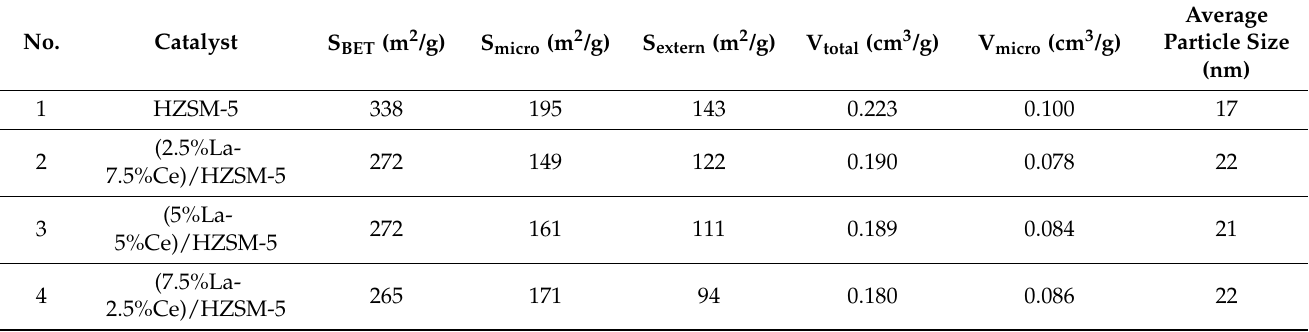
Table 2. Texture properties of the parent HZSM-5 and Lanthanum-Cerium-modified HZSM-5 with different loading weight percentages of modified HZSM-5.